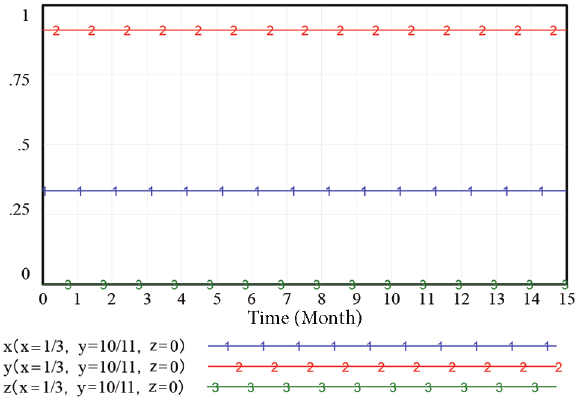
Figure 6. Game results under the initial hypothesis